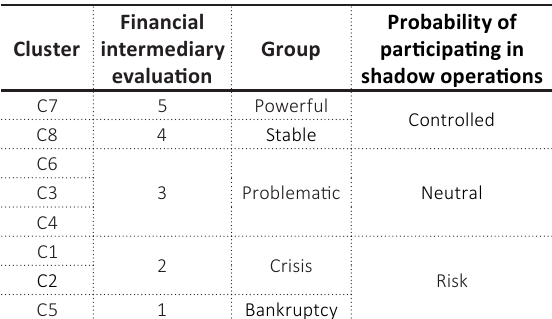
Table 13. Assessment of conditional financial intermediaries by new groups within clusters